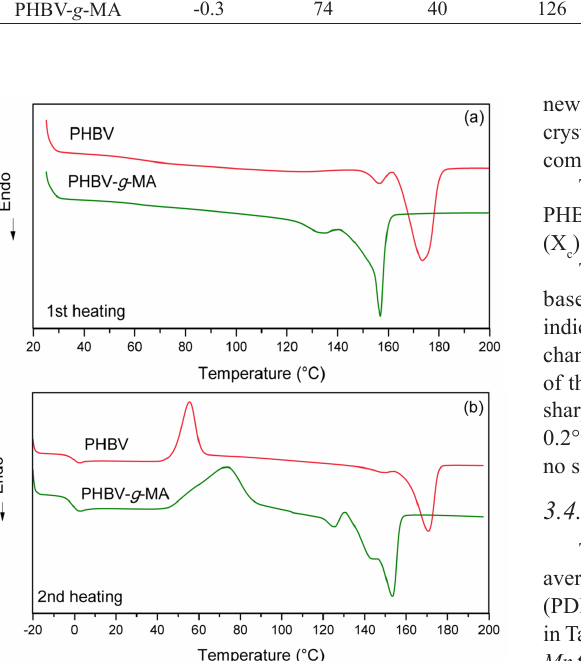
) on second heating scan for neat PHBV and PHBV- g -MA. g